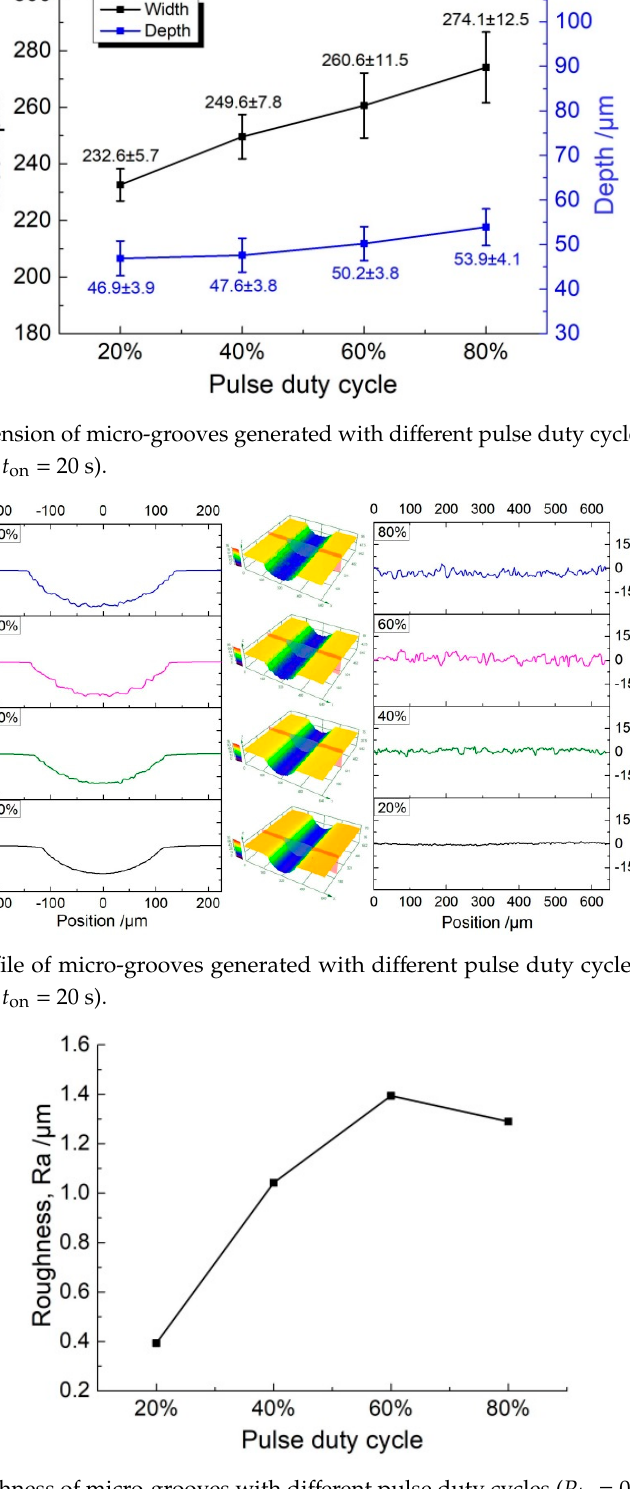
Figure 14. The roughness of micro-grooves with different pulse duty cycles ( P in = 0.8 MPa, U = 35 V, f = 1 kHz, t on = 20 s).